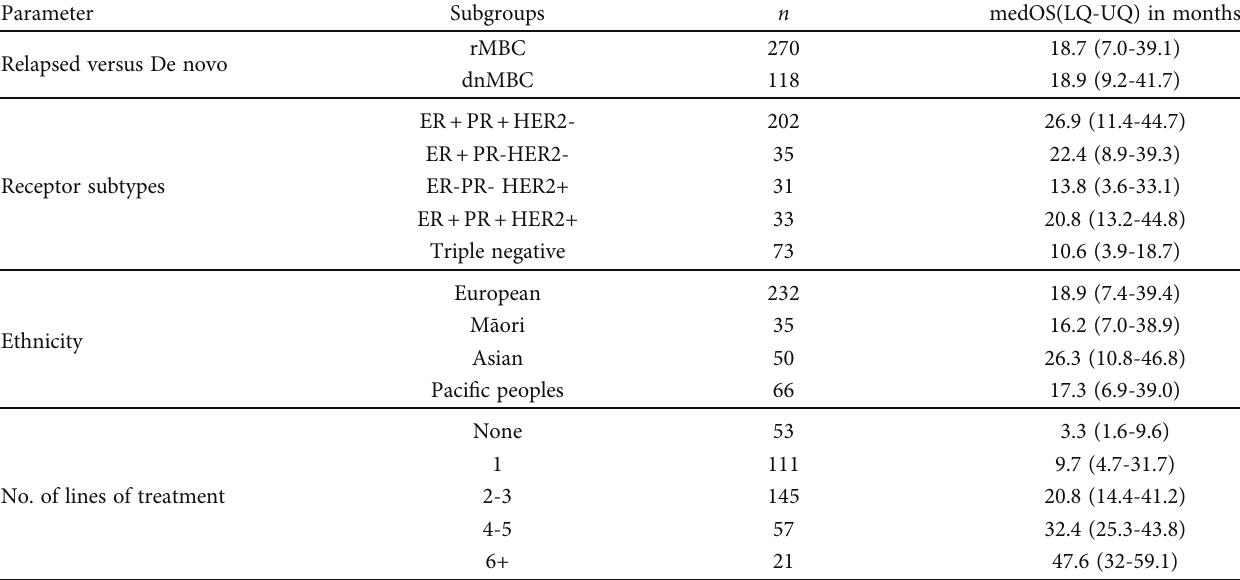
Table 2: Key survival